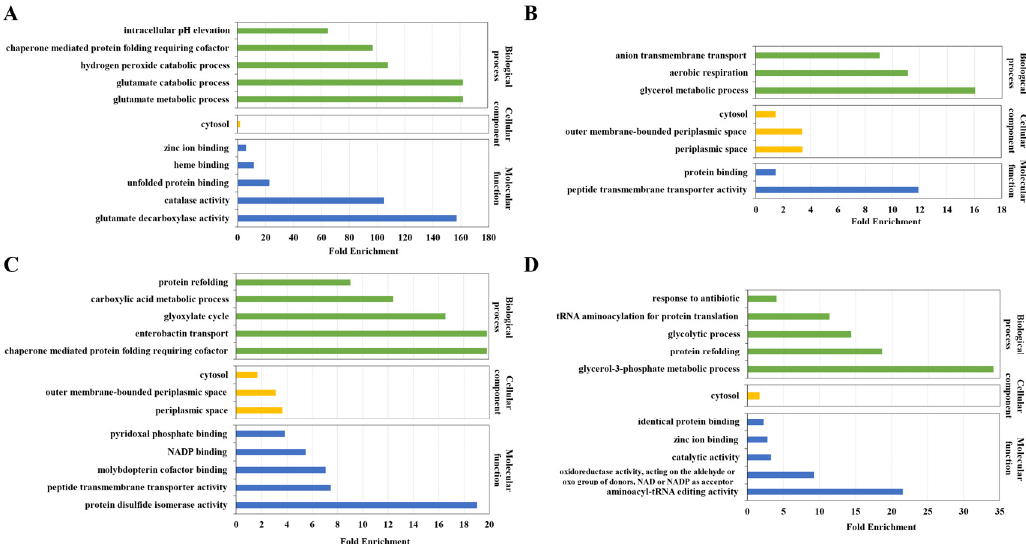
Figure 4. Gene ontology analysis for the proteins corresponding to the down/upregulated dityrosine-linked peptides. ( A ) Gene ontology (biological process (TOP5 of fold enrichment), cellular component, and molecular function (TOP5 of fold enrichment)) analysis for the proteins which corresponded to the dityrosine-linked peptides downregulated in E. coli MG1655/ ∆ Ahp ∆ KatE ∆ KatG, when comparing E. coli MG1655/ ∆ Ahp ∆ KatE ∆ KatG and E. coli MG1655/ ∆ Ahp . ( B ) Gene ontology (biological process, cellular component, and molecular function) analysis for the proteins which corresponded to the dityrosine-linked peptides upregulated in E. coli MG1655/ ∆ Ahp ∆ KatE ∆ KatG, when comparing E. coli MG1655/ ∆ Ahp ∆ KatE ∆ KatG and E. coli MG1655/ ∆ Ahp . ( C ) Gene ontology (biological process (TOP5 of fold enrichment), cellular component, and molecular function (TOP5 of fold enrichment)) analysis for the proteins which corresponded to the dityrosine-linked peptides downregulated in E. coli MG1655/ ∆ Ahp ∆ KatE ∆ KatG with 1 mM H 2 O 2 , when comparing E. coli MG1655/ ∆ Ahp ∆ KatE ∆ KatG with 1 mM H 2 O 2 and E. coli MG1655/ ∆ Ahp ∆ KatE ∆ KatG . ( D ) Gene ontology (biological process (TOP5 of fold enrichment), cellular component, and molecular function (TOP5 of fold enrichment)) analysis for the proteins which corresponded to the dityrosine-linked peptides upregulated in E. coli MG1655/ ∆ Ahp ∆ KatE ∆ KatG with 1 mM H 2 O 2 , when comparing E. coli MG1655/ ∆ Ahp ∆ KatE ∆ KatG with 1 mM H 2 O 2 and E. coli MG1655/ ∆ Ahp ∆ KatE ∆ KatG